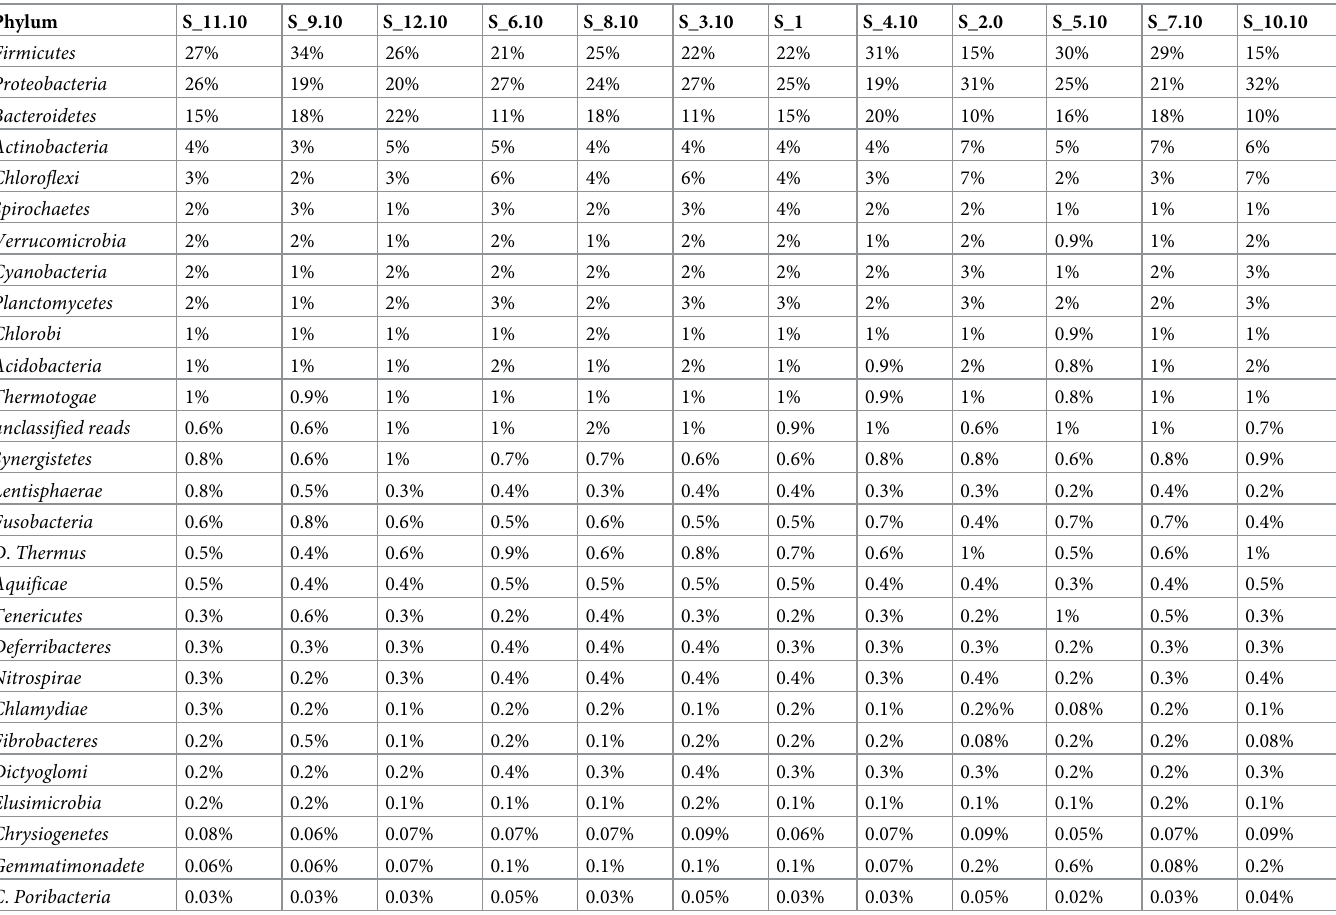
Table 1. The Krona software generated Bacterial phyla biomes of the twelve treatments within eastern and central regions of Kenya. Phylum S_11.10 S_9.10 S_12.10 S_6.10 S_8.10 S_3.10 S_1 S_4.10 S_10.10 Firmicutes 27% 34% Proteobacteria 26% Bacteroidetes Actinobacteria Spirochaetes Verrucomicrobia Cyanobacteria 2% 3% Planctomycetes 2% 1% Chlorobi 1% Acidobacteria 1% 1% 1% Thermotogae 1% 0.9% unclassified reads Lentisphaerae